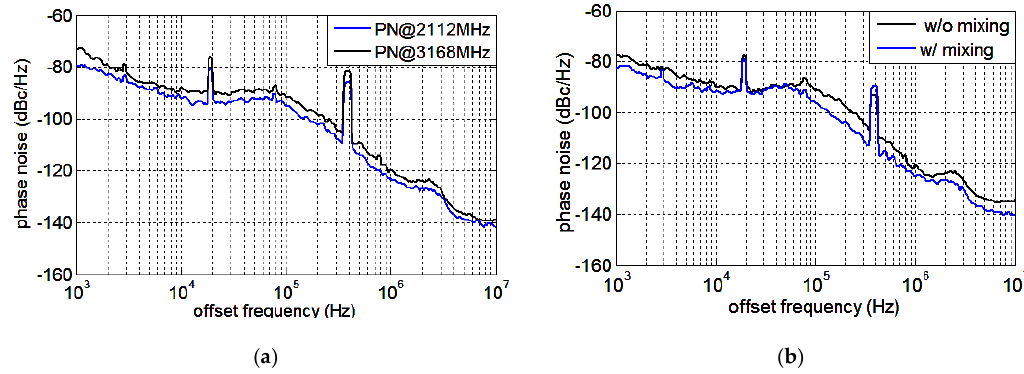
Figure 16. Phase noise measurement results: ( a ) at the input 2112 MHz and output 3168 MHz; ( b ) the same frequency produced by PLL directly or by mixer indirectly at 2376 MHz.